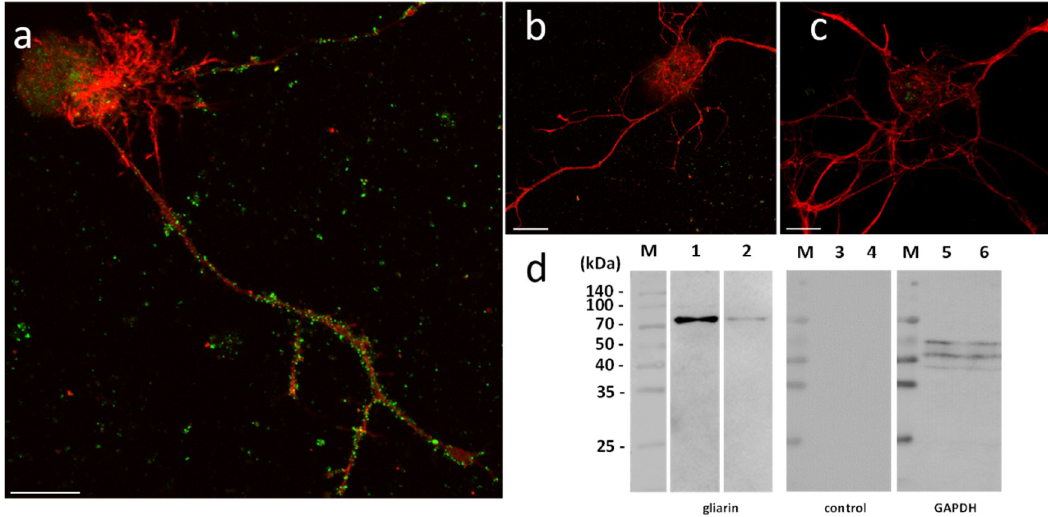
Figure 5. Immunofluorescence analyses of leech nerve cell cultures. ( a ) Neuron-microglia co-cultures immunostaining with mouse monoclonal anti-gliarin antibody revealed the presence of positively stained vesicles (green) associated to neurites. ( b ) The immunostaining with anti-gliarin did not reveal the presence of immunopositive vesicles in a culture of leech neurons alone. ( c ) No specific signal was observed in the same culture treated with the secondary antibody alone as control. Neuron cell bodies were counterstained with rhodamine-conjugated phalloidin (red). Scale bars correspond to 20 µm. ( d ) A unique 75 kDa positive signal was immunodetected in microglia-derived EV (lane 1) as well as in microglial cell (lane 2) protein extracts, confirming the presence of gliarin-positive EVs. No signal was observed on the same samples using secondary antibodies alone as negative control (lanes 3 and 4). Western blot analysis was performed on the same control membrane using anti-GAPDH antibody as a loading control (lanes 5 and 6). Molecular weights (M) are reported.